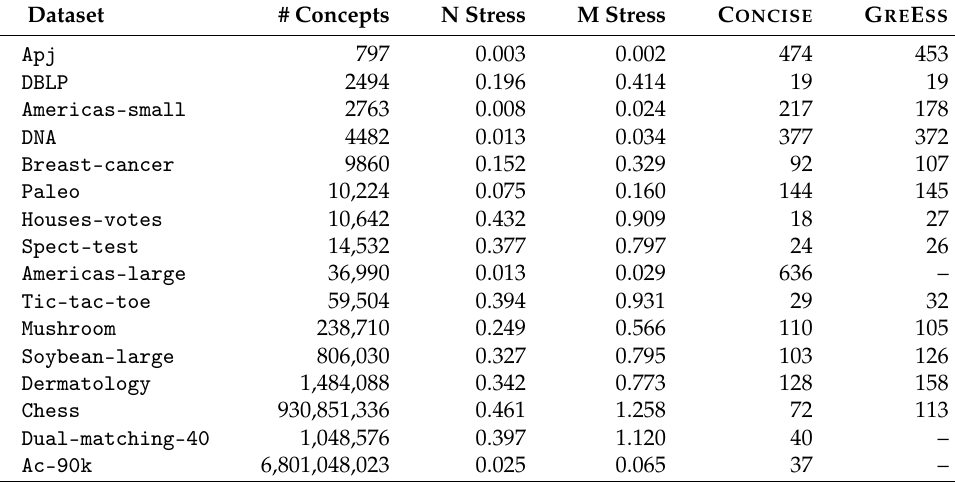
Table 8. Comparison between C ONCISE and G RE E SS algorithms on the criterion of the coverage minimality. (–) means that we were unable to obtain a result after 48 h.